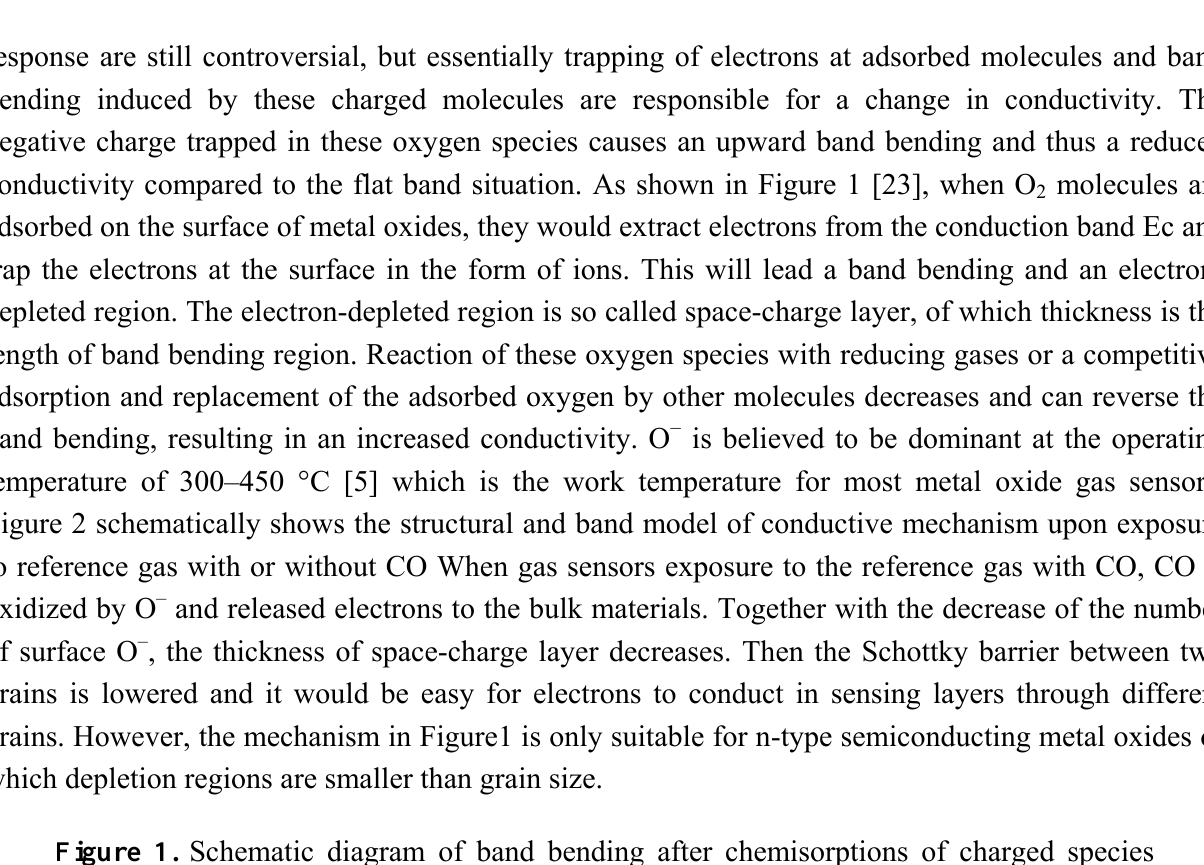
Figure 1. Schematic diagram of band bending after chemisorptions of charged